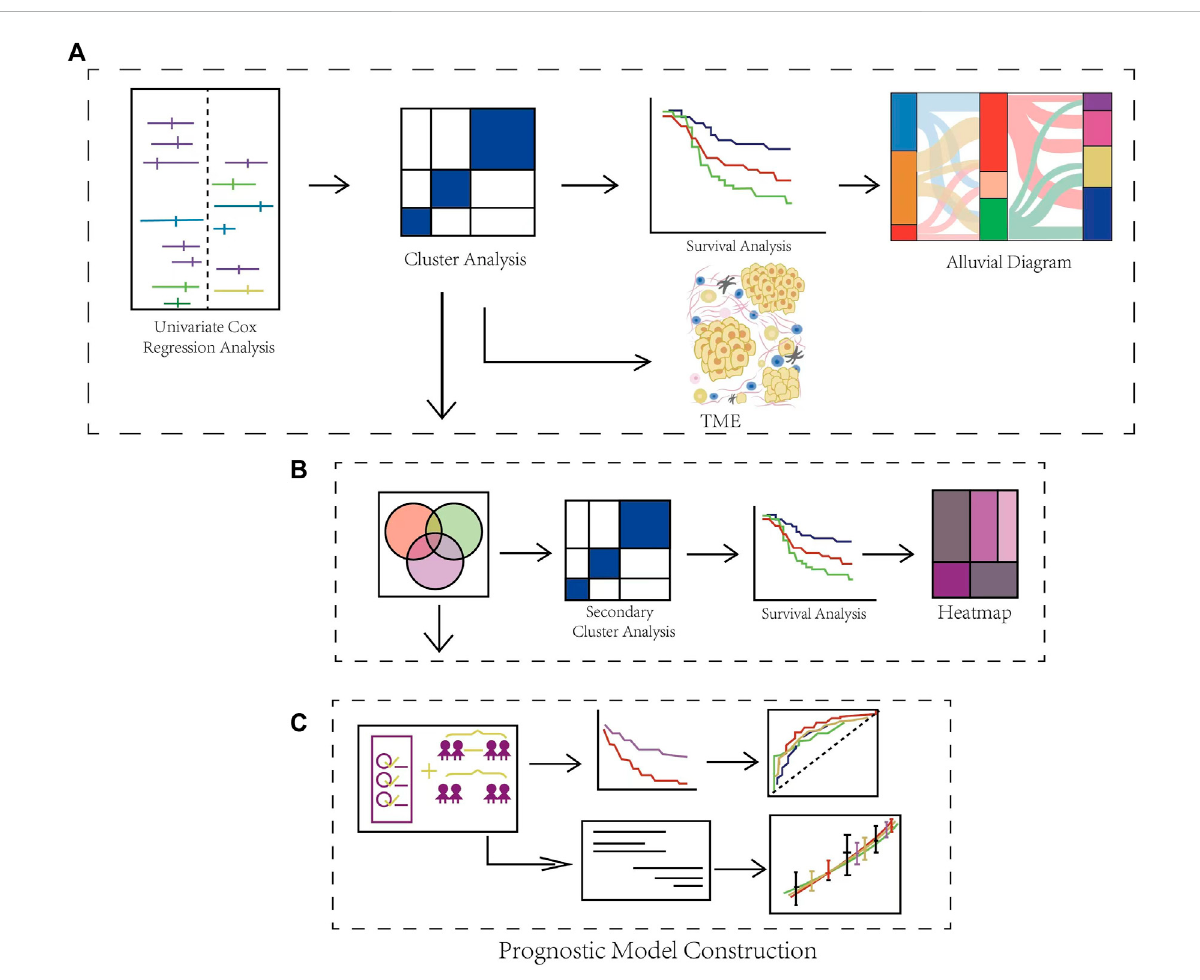
FIGURE 1 Schematic Diagram of the Overall Flow of the Study. (A) Identi fi cation of DLBCL-associated necroptosis-related clusters and immune in fi ltration analysis. (B) Identi fi cation of differential expression genes in necroptosis-related clusters. (C) Construction and validation of a gene prognostic model and the evaluation of prognostic